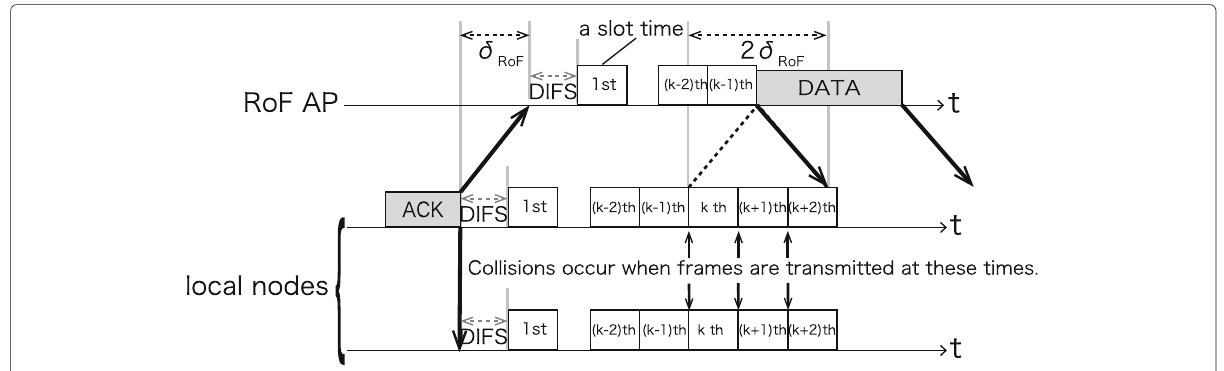
Fig. 2 Frame collision between RoF AP and local nodes